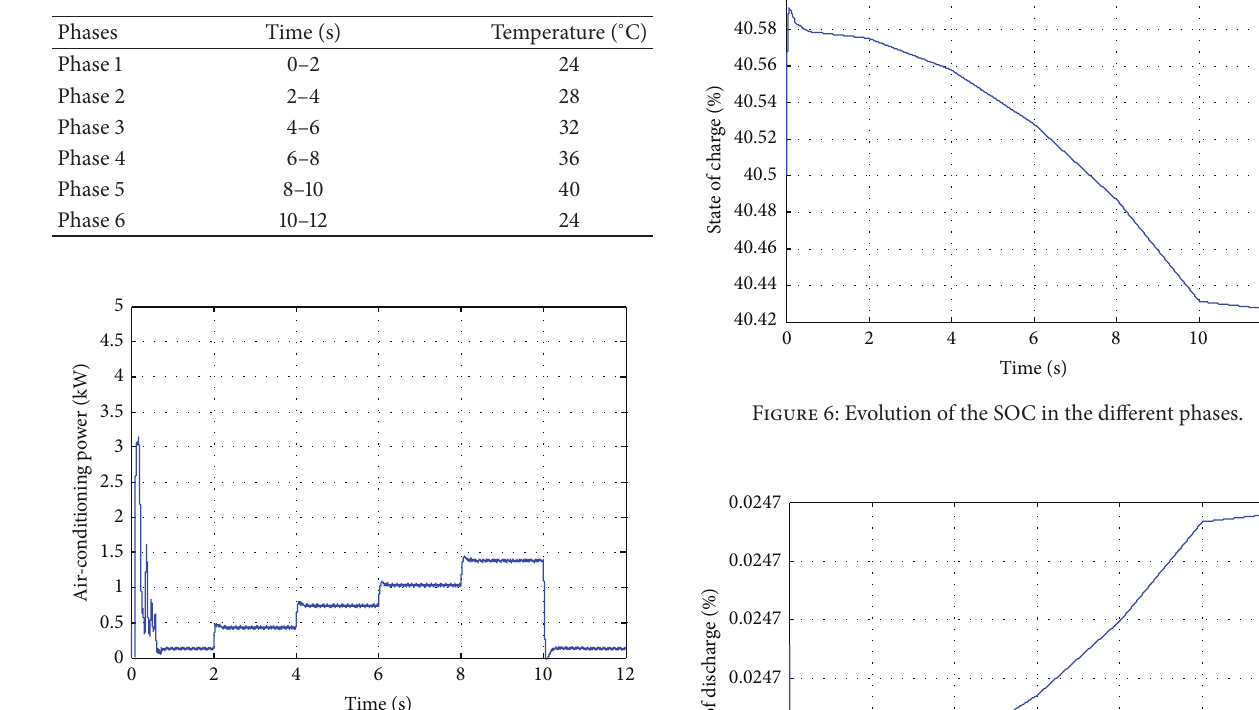
Table 1: Different climatic conditions.